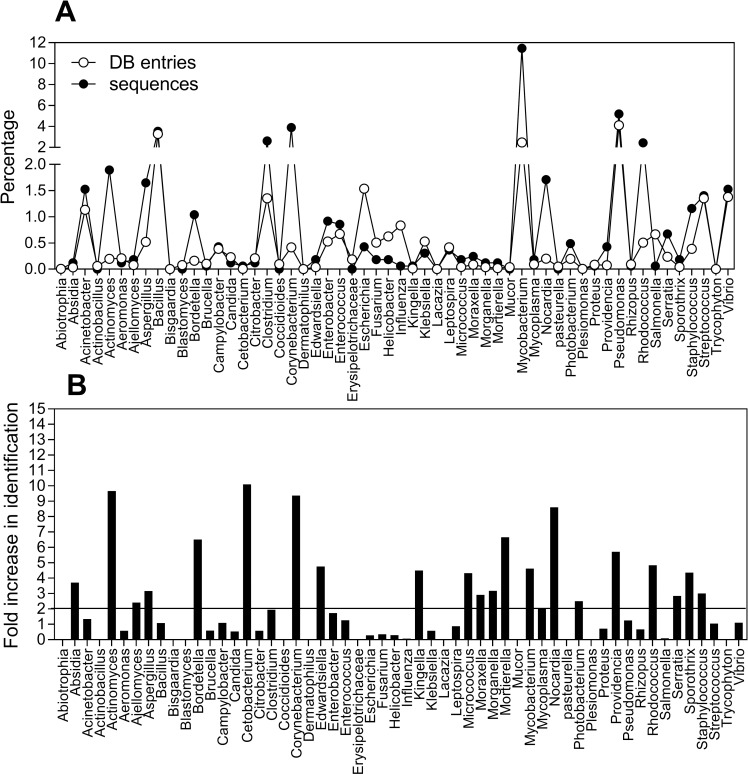
Relative occurrence of genera in UniProt database and in current search for marine related pathogens.A. Percentage of entries for named genera in the database compared to the percentage of sequences identified in named genera derived from MPSLA. B. Fold increase in identification of named genera.